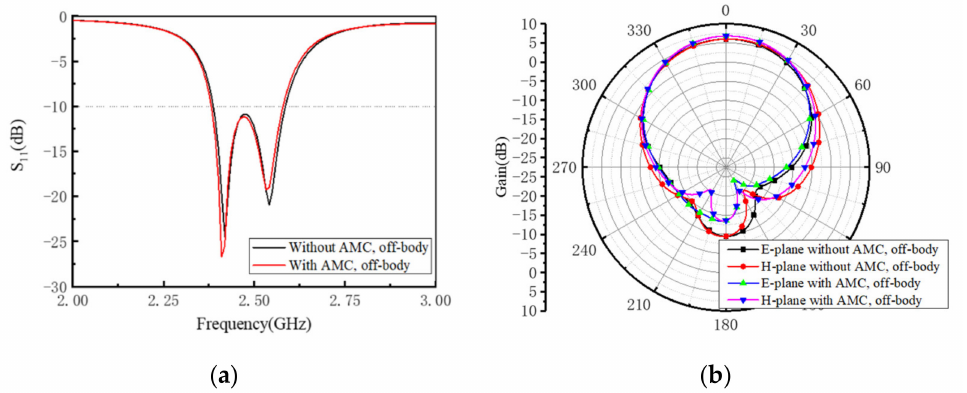
Figure 10. The measured return loss ( a ) and radiation pattern ( b ) of textile slotted microstrip antenna with and without AMC at 2.45